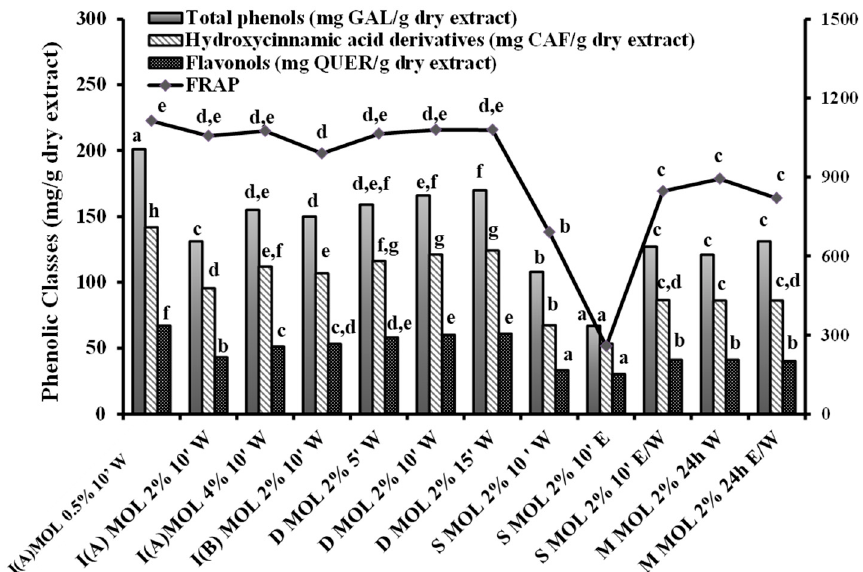
Figure 2. Total phenols, total hydroxycinnamic acid derivatives, total flavonols and ferric reducing ability (FRAP) of Melissa Officinalis L. (MOL) preparations of same extract weight basis.